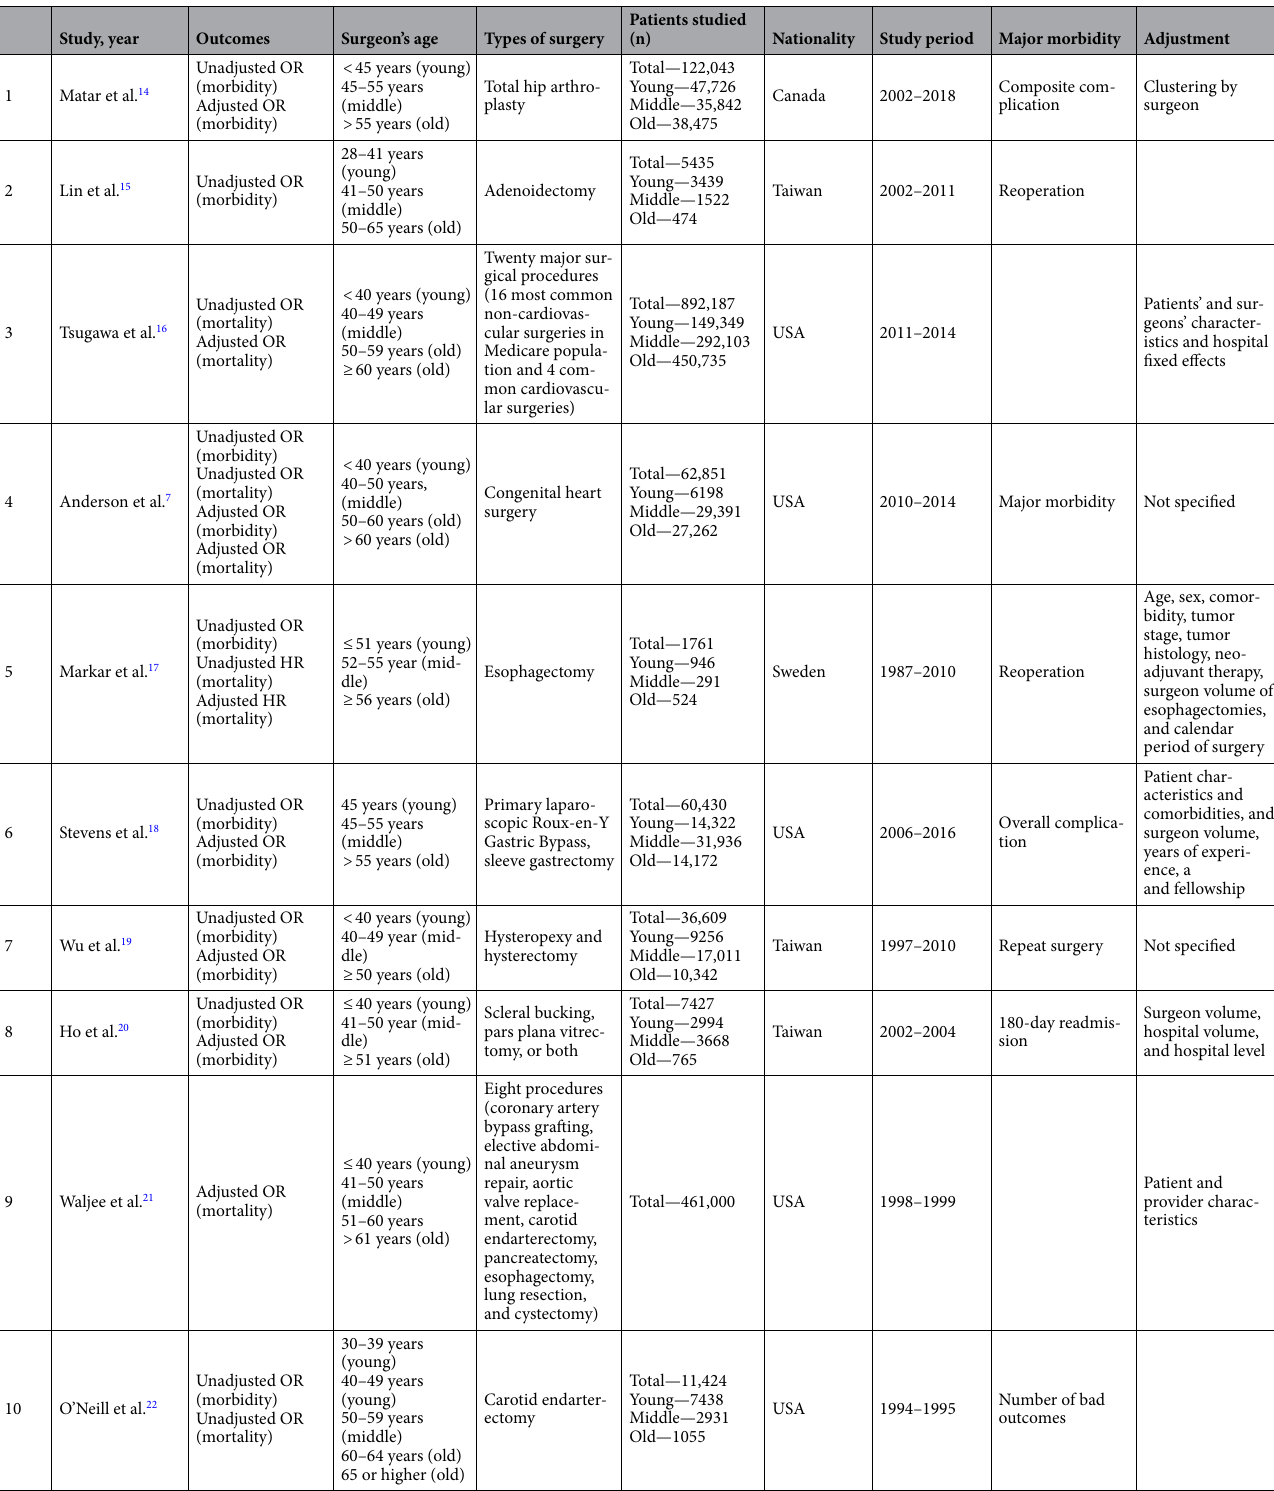
Table 1. Characteristics of the studies included for the